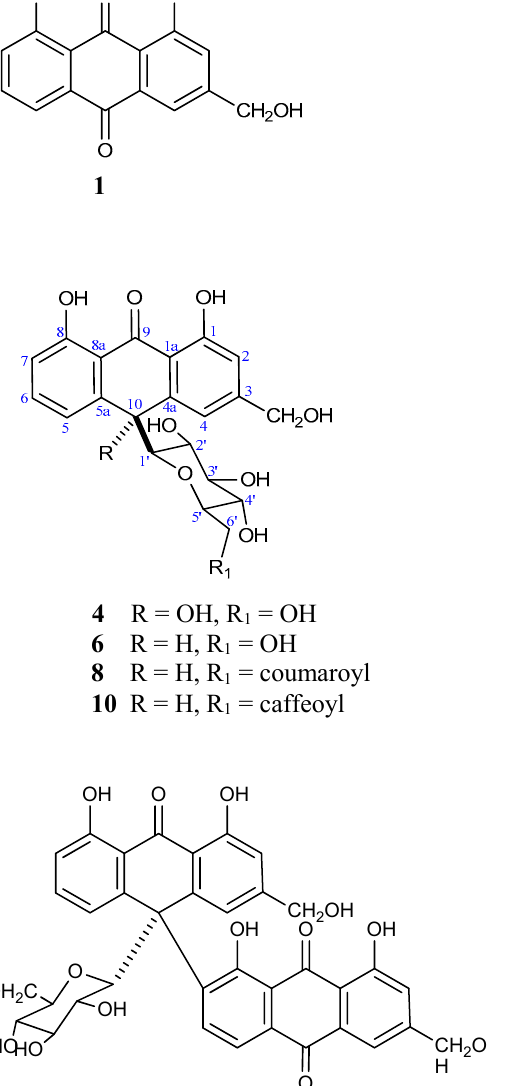
Figure 1. Chemical structures of the isolated compounds ( 1–12 ) from A. vacillans (Glc = glucose).